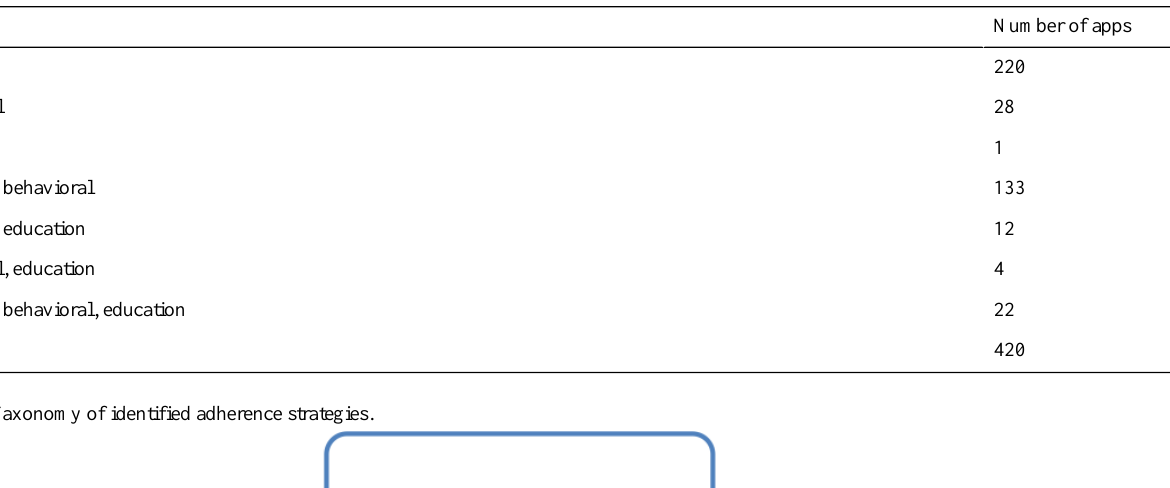
Table 1. Numbers of apps adopting the various adherence strategies.